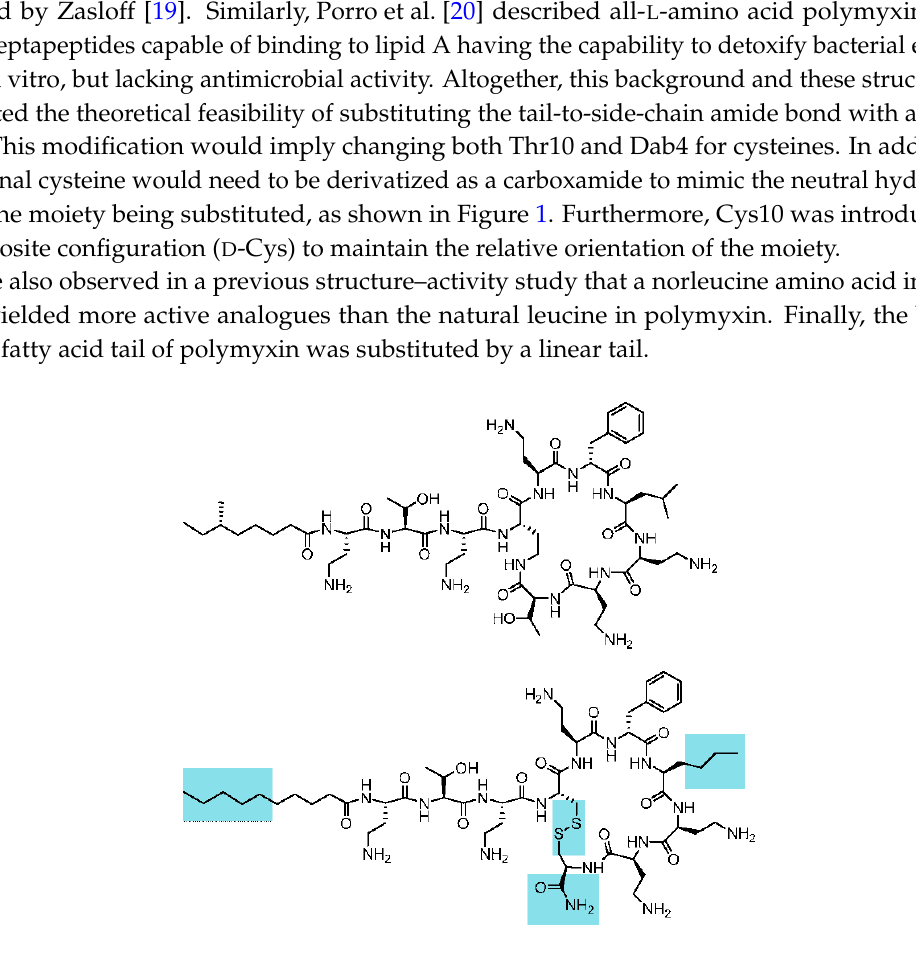
Figure 1. Chemical structure of the cyclolipopeptide analogue of polymyxin AMP38 ( below ) and of natural polymyxin B ( above ). The structural and chemical features modified in the analogue with respect to polymyxin are highlighted in blue.